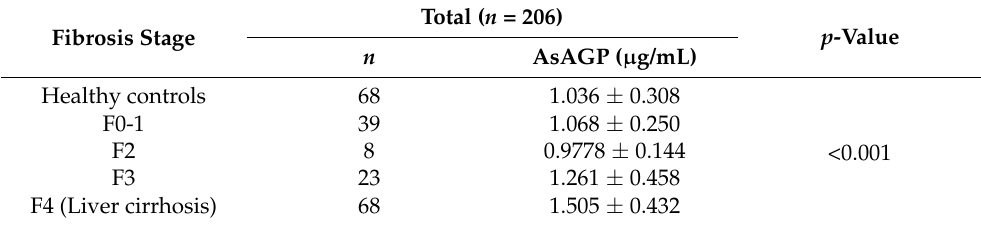
Table 3. Serum AsAGP levels according to fibrosis